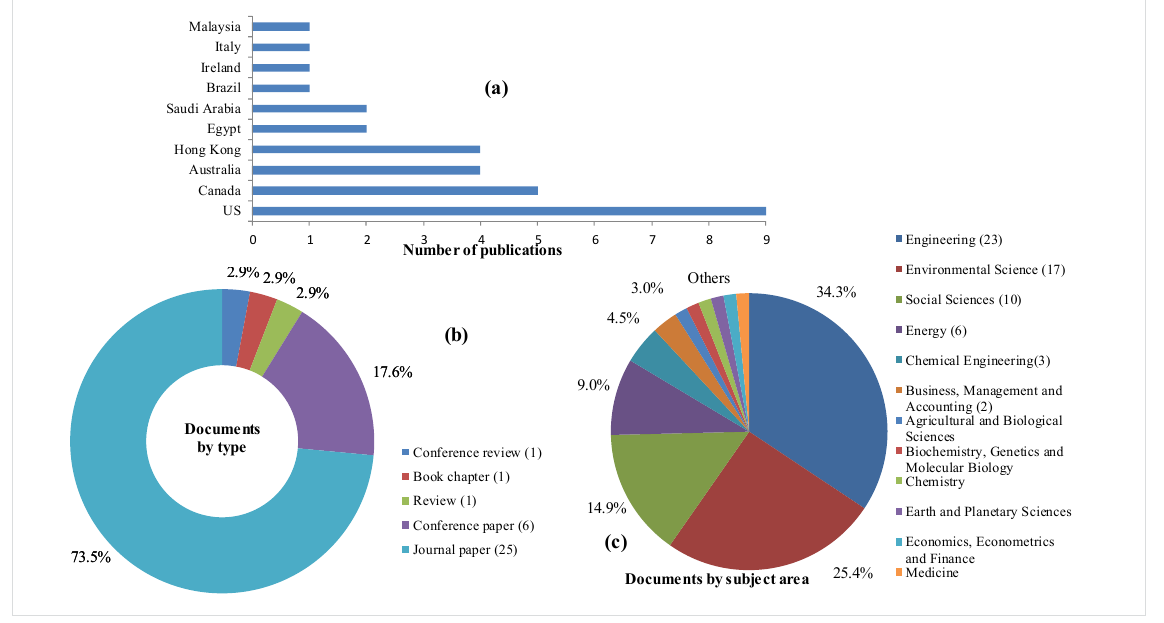
Figure 3. Search results analysis. ( a ) The number of documents by country or territory; ( b ) Documents by type; and ( c ) Documents by subject area.